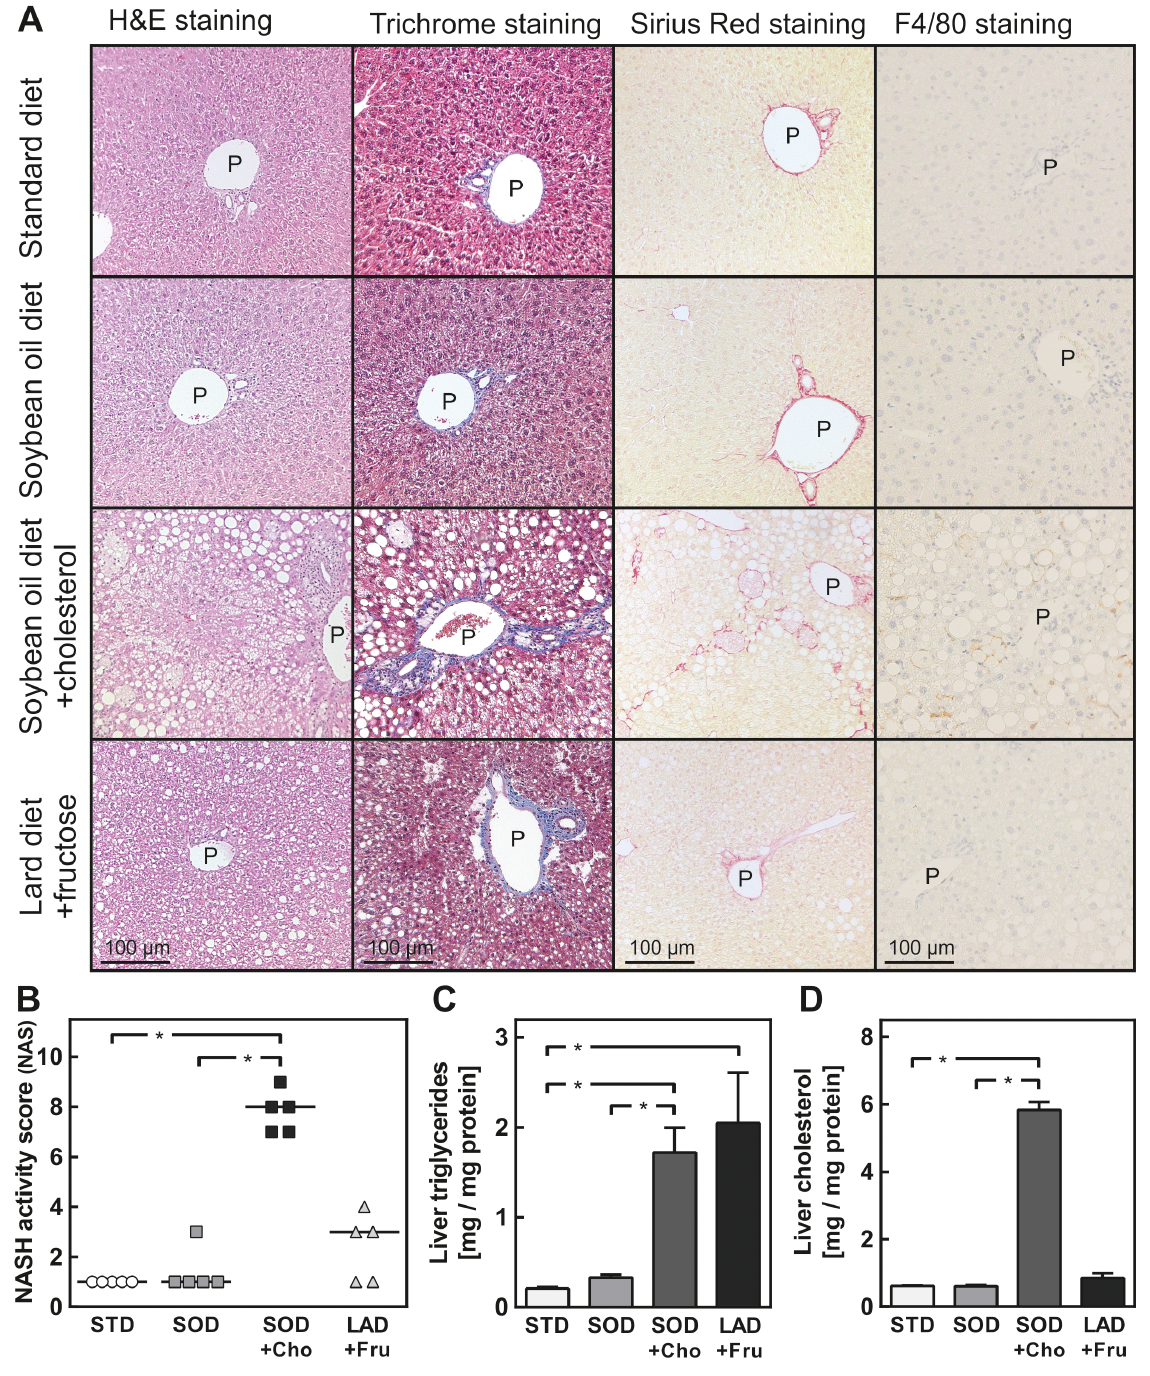
Figure 1. Dietary cholesterol in soybean oil diet enhanced NASH activity score, liver triglycerides and liver cholesterol. Mice were fed a standard diet (STD), soybean oil diet (SOD), soybean oil diet + 0.75% cholesterol (SOD + Cho) or lard diet + fructose in drinking water (LAD + Fru) for 20 wks. (A) Representative microphotographs of liver histology, magnification 20 ×. P: portal tract. (B) NASH activity score grading steatosis, ballooning (hypertrophy), inflammation and fibrosis. (C) Liver triglyceride and (D) liver cholesterol content per mg protein. Values represent (B) single score values and median per group or (C,D) mean ± standard error of the mean of 5 mice per group. Statistics: (B) Mann-Whitney U test, *p <0.05. (C, D) One-way analysis of variance with Dunnett’s post hoc test or, where appropriate, Tukey’s post hoc test for multiple comparisons, *p